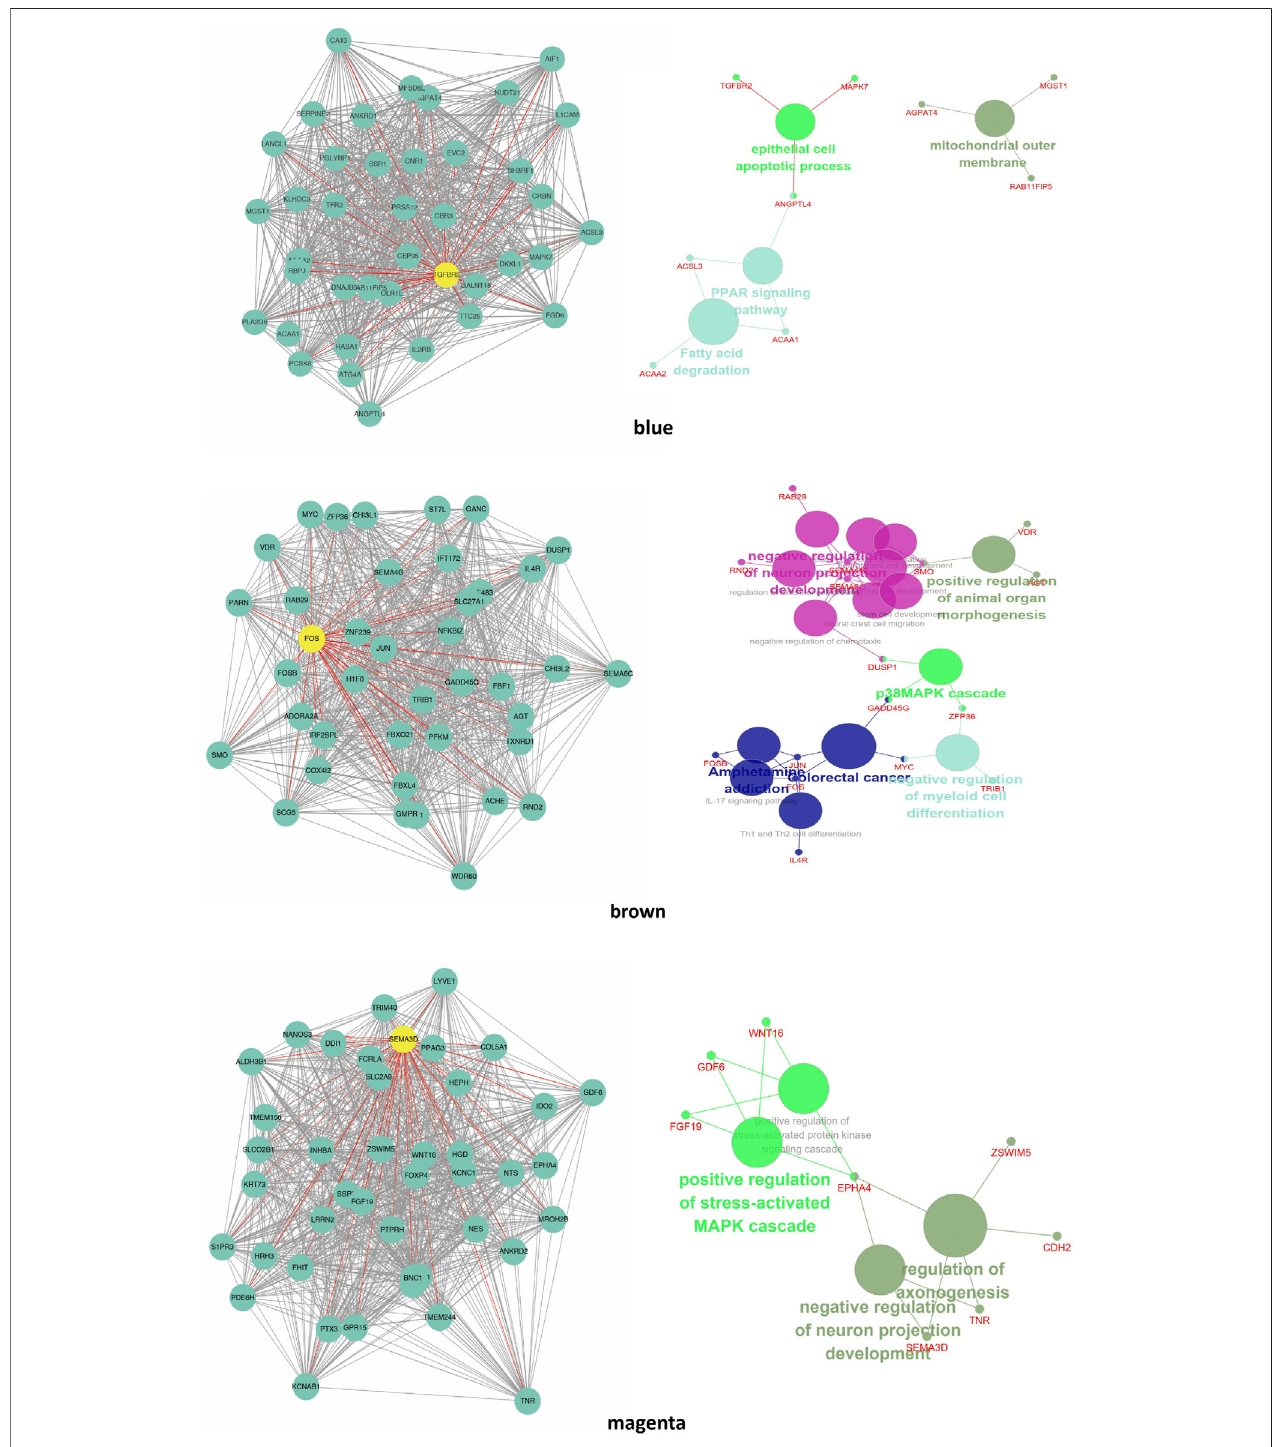
FIGURE5| Visualizationofmodules.Thenetworkdiagramisshownontheleft,andtheenrichmentanalysisisontheright.Thehubgenesinthemodulesareboldinyellow.